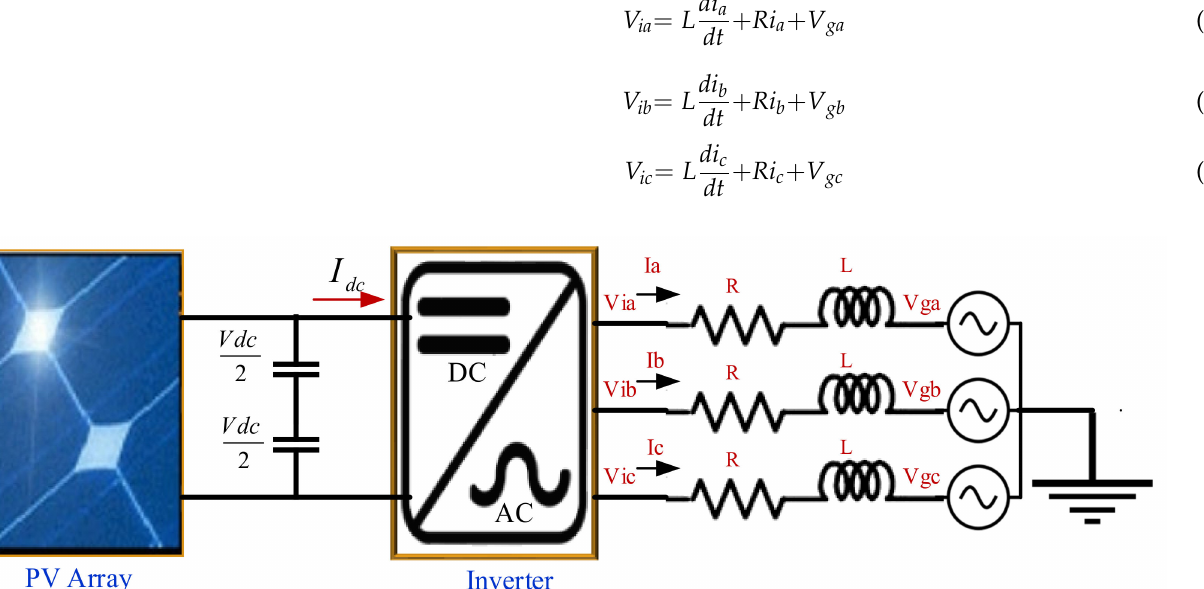
Figure 5. Three-phase view of a grid-connected voltage source